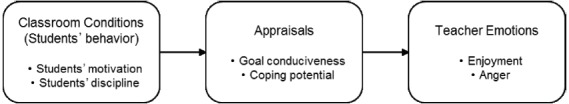
Figural representation of the present study’s key assumptions based on Frenzel et al.’s (2009b) model on the antecedents of teachers’ emotions.